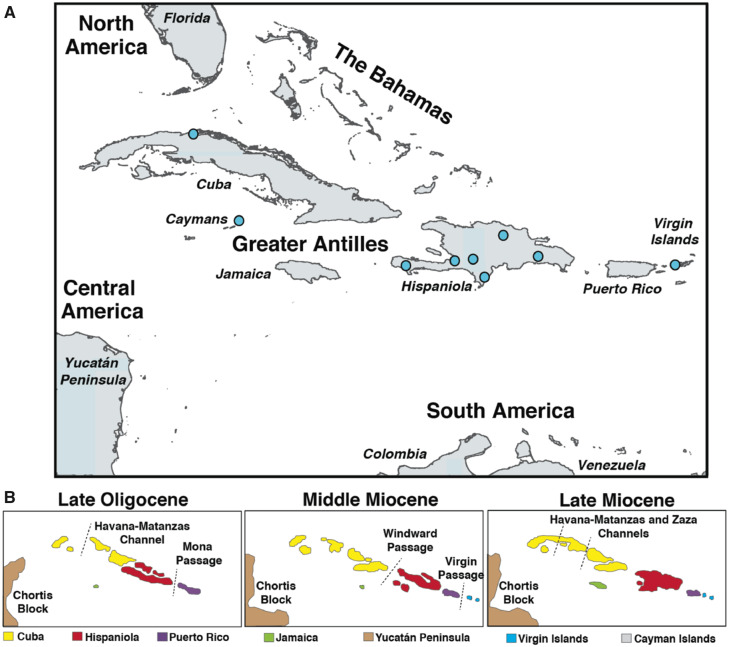
Sampling localities (A) and geologic history of the Caribbean (B), map information sourced from Cooke et al. (2011), Fabre et al. (2014), Matos-Maraví et al. (2014) and Svenson and Rodrigues (2017).